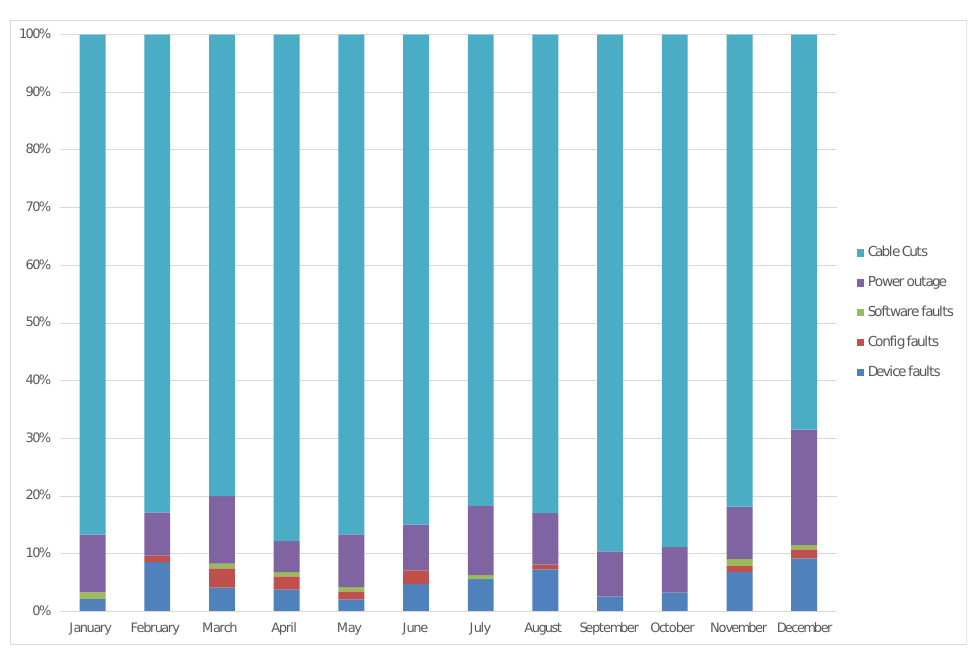
Figure 4. The bit errors include both bit-interleaved parity (BIP) errors, which